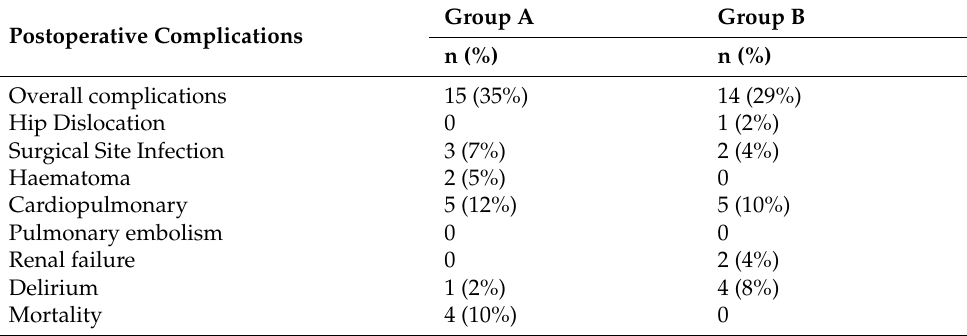
Table 3. Overview of